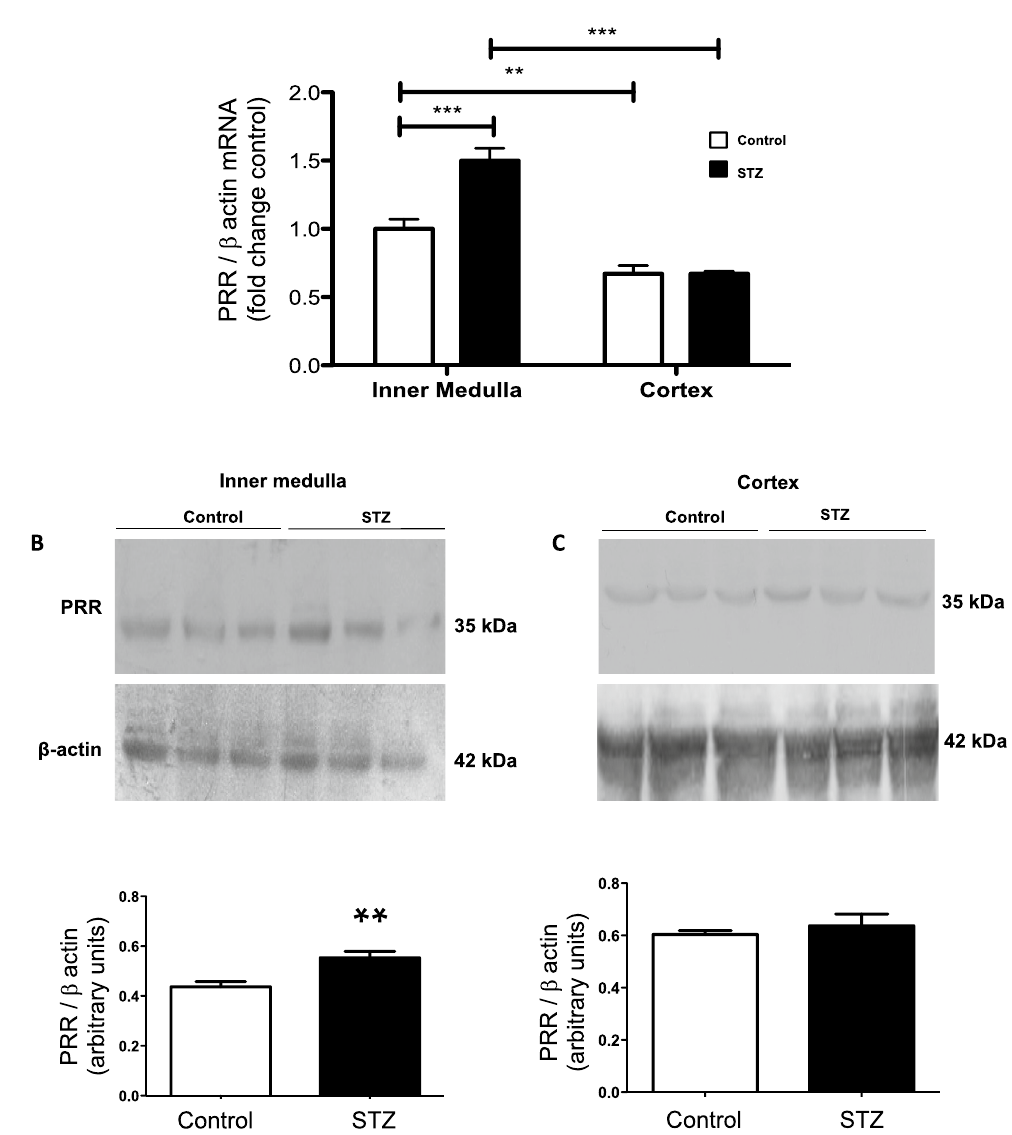
Figure 4. Prorenin receptor is increased in medullary tissues of diabetic rats. ( A ) PRR mRNA levels were augmented in the renal medulla in STZ rats. No differences were found in the cortex. ( B )